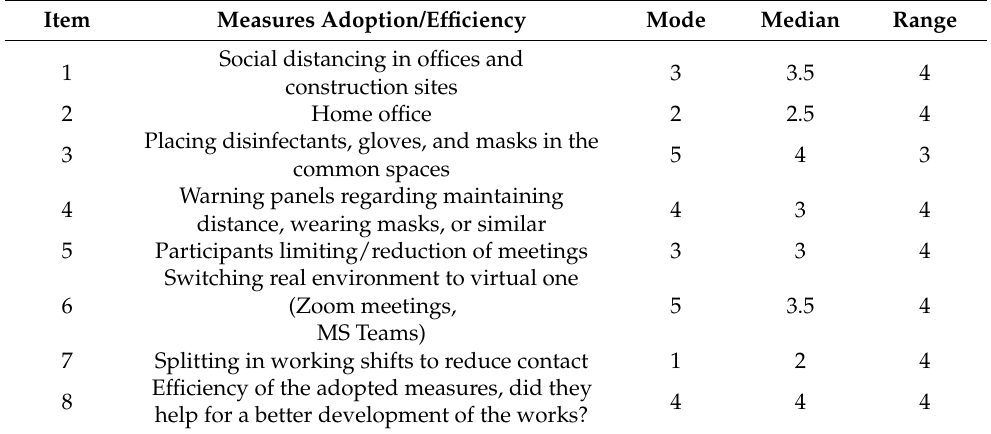
Table 4. Responses obtained for the section adoption and efficiency of COVID-19 stopping